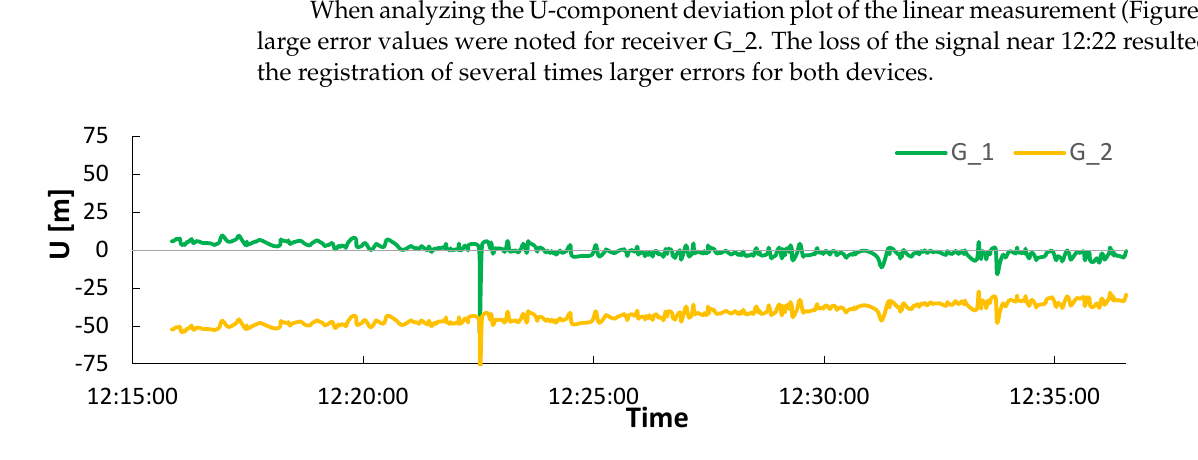
Figure 10. Plot of U-component deviations of linear measurement with code receivers.